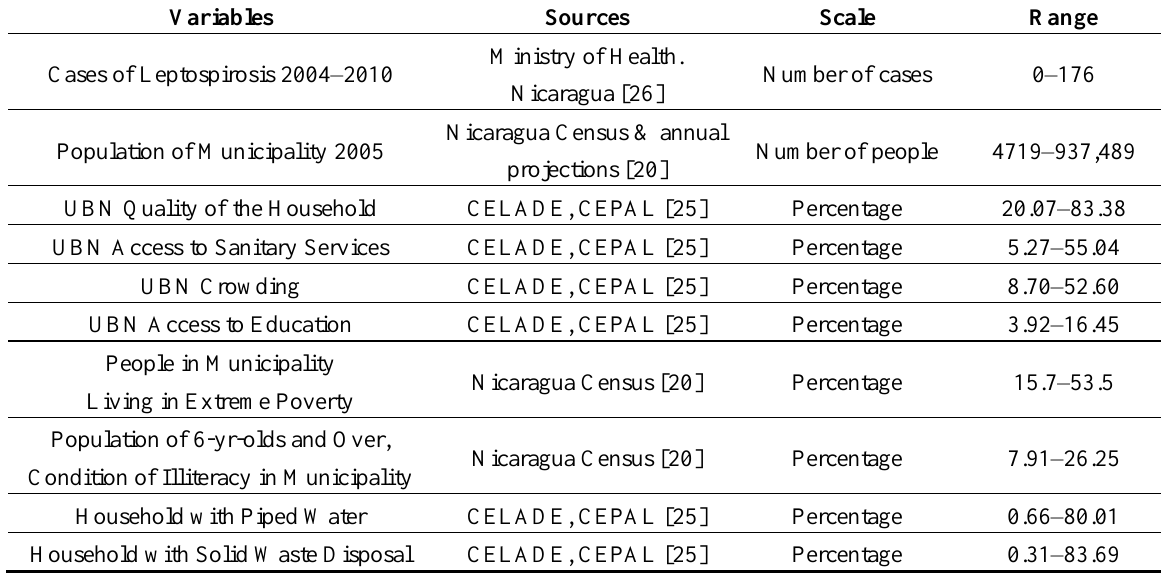
Table 1. Variables and sources of information used in the